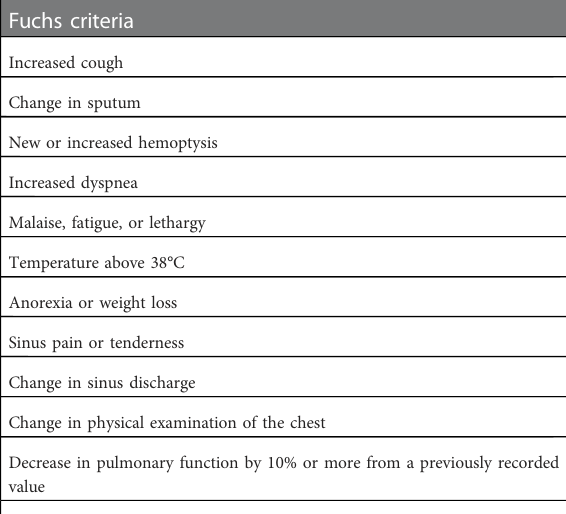
TABLE 1 Original fuchs criteria: at least 4 out of 12 of the following signs and symptoms must be present for respiratory tract exacerbation diagnosis.